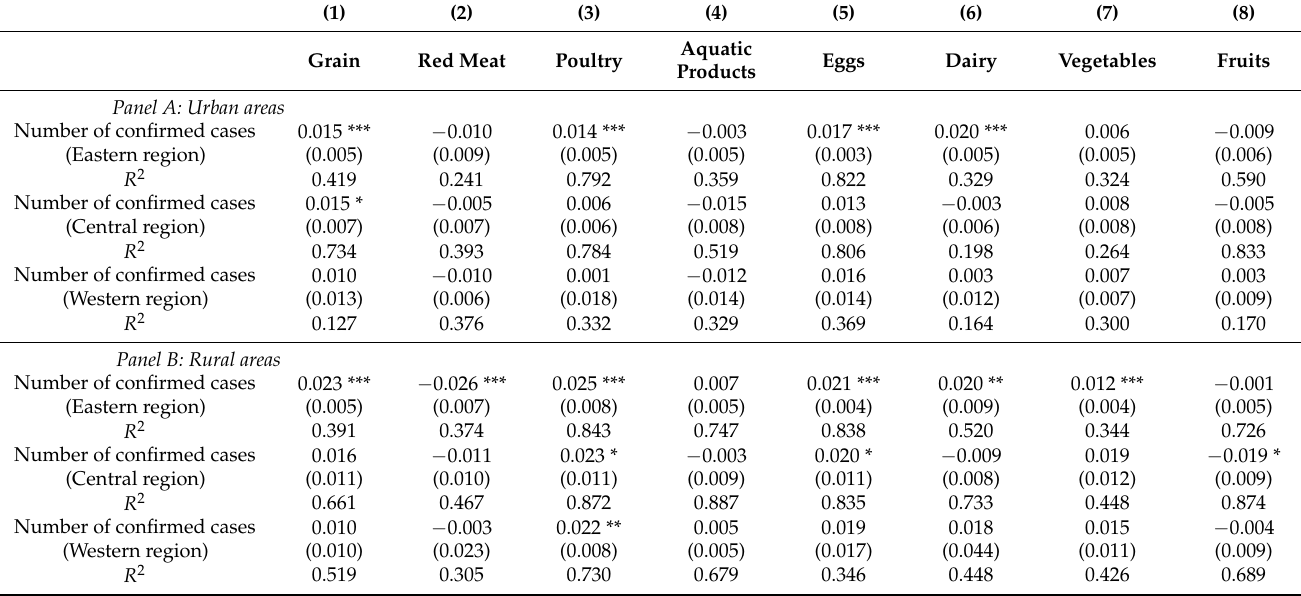
Table 3. Impacts of COVID-19 on urban and rural dietary consumption: heterogeneity by region.